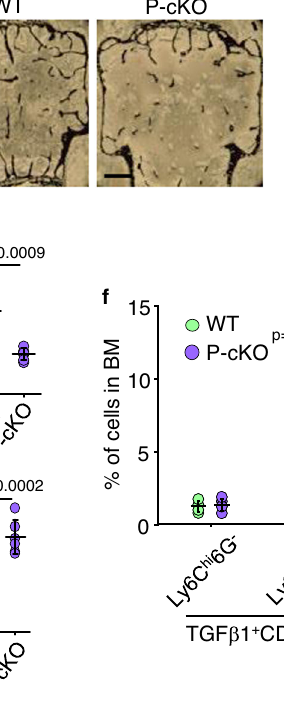
biologically independent male mice/group). e TRAP-stainedparaf fi n sections of L2 vertebrae and OC numbers (Oc.N/B.S). Bar=50 μ m. Mean±SD ( n =8 biologically independent male mice/group). f , g Frequencies and numbers of TGF β 1 + CD11b + Ly6C hi 6G - and TGF β 1 + CD11b + Ly6C - 6G + in BM from15-mon-oldWTand P-cKOmice. Mean±SD ( n =5 biologically independent male mice/group). Analyses: Student ’ s two-sided unpaired t test. Source data are provided as a Source data fi